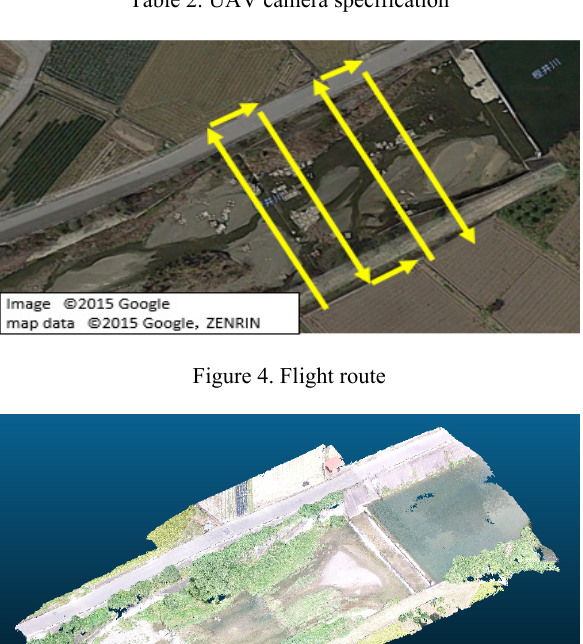
Table 2. UAV camera specification